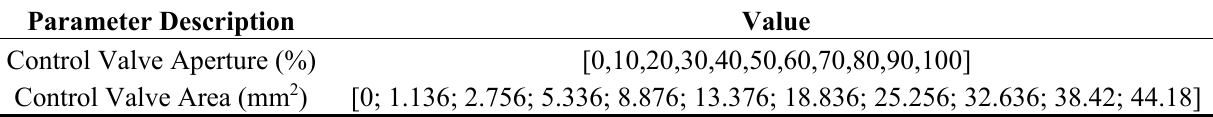
Figure 28. PTO Output. Hydraulic motor speed (rpm) comparison between simulated (red) and experimental (blue) tests. Table 11. Control valve aperture percentage versus control valve